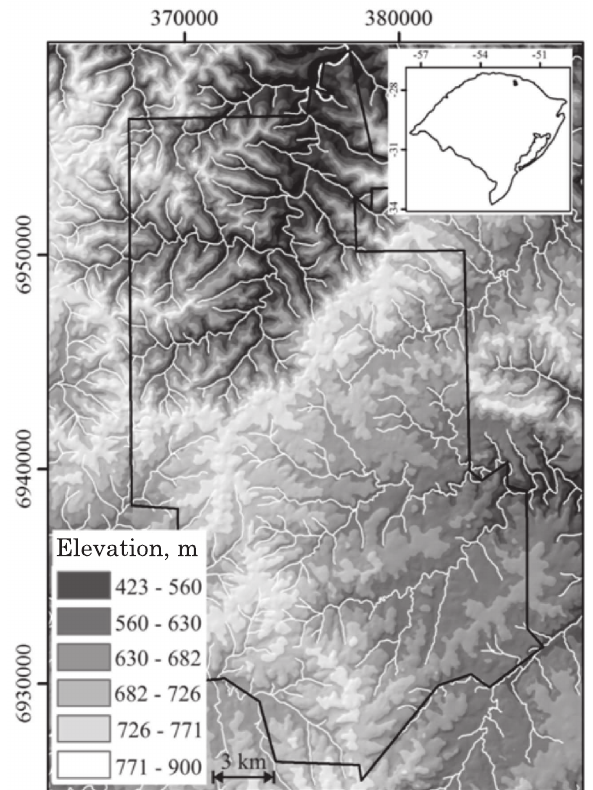
Figure 1. Drainage network and hypsometric map of the study area overlaid by the perimeter of the municipality of Erechim. The inset in the upper right corner shows the study area in the State of Rio Grande do